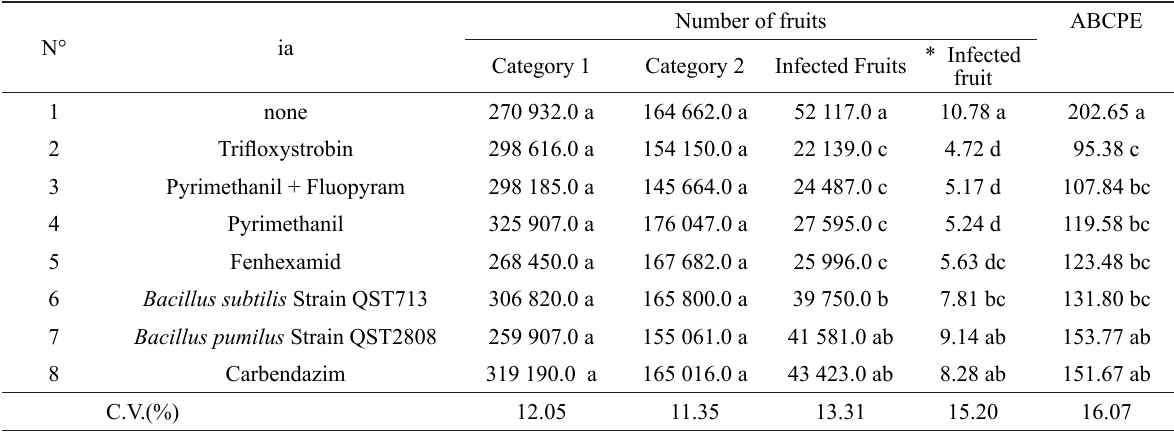
Table 4. Effect of chemical and biological fungicides on the number of Strawberry cv. Aromas and Area under the Botrytis cinerea Progress Curve in field conditions